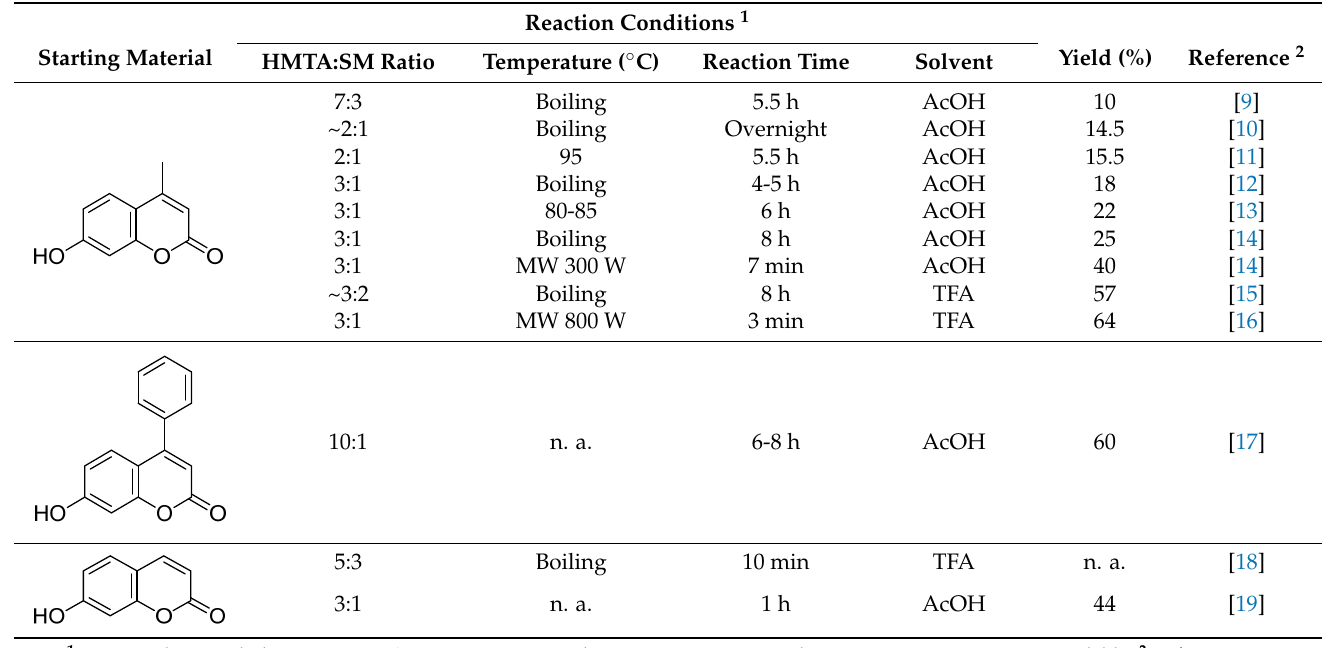
References to Table 1 are compliant with those presented below in the general References section.